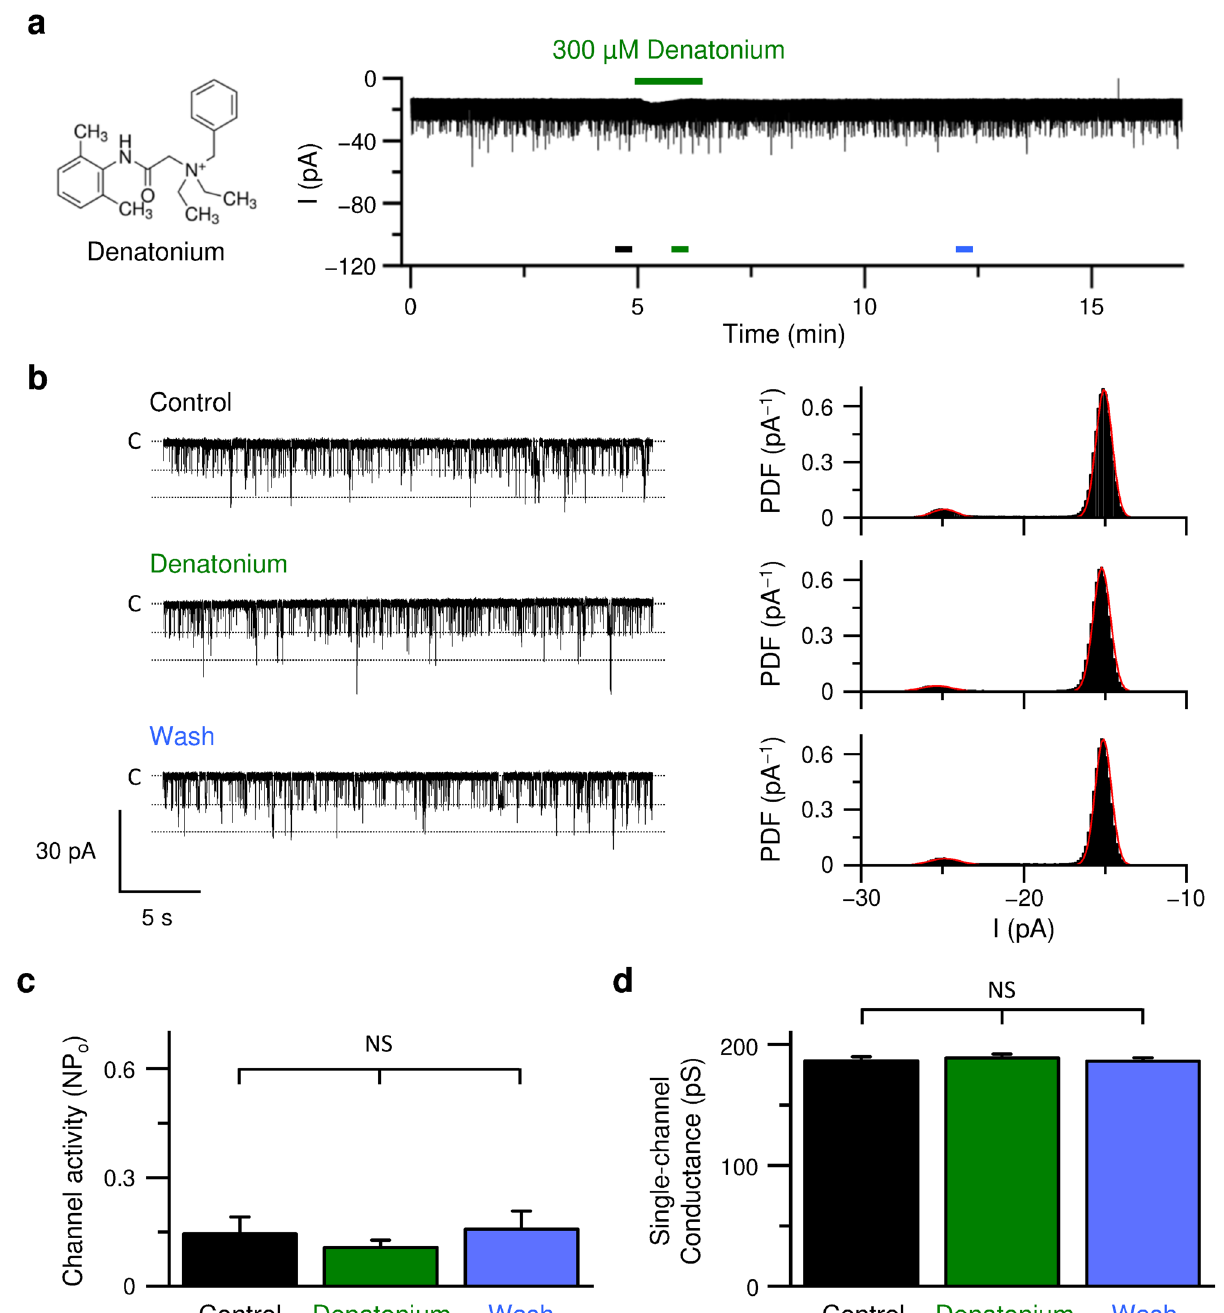
Figure 2. Denatonium had no effect on the PKD2L1 activity. ( a ) Whole-cell PKD2L1 current recorded at − 60 mV in HEK293T cells exogenously expressing PKD2L1. Denatonium (300 µM) was added as indicated by an upper green line . ( b ) Time-expanded traces from the horizontal bars ( black , green, and blue ) in ( a ). The traces before (Control, black ), during (Denatonium, green ), and after (Wash, blue ) application of denatonium are shown. Dotted lines indicate closed (C) and open levels. The corresponding all-points amplitude histograms are shown on the right. PDF stands for probability density function. Gaussian fittings are shown in red lines . ( c , d ) The channel activity (NPo) ( c ) and the single-channel conductance ( d ) before (Control), during (Denatonium), and after (Wash) application of denatonium. The data are averaged from nine experiments. P values are determined by one-way ANOVA with Tukey’s post-hoc analysis (F = 0.41 in c and F = 0.23 in d ). NS, P >